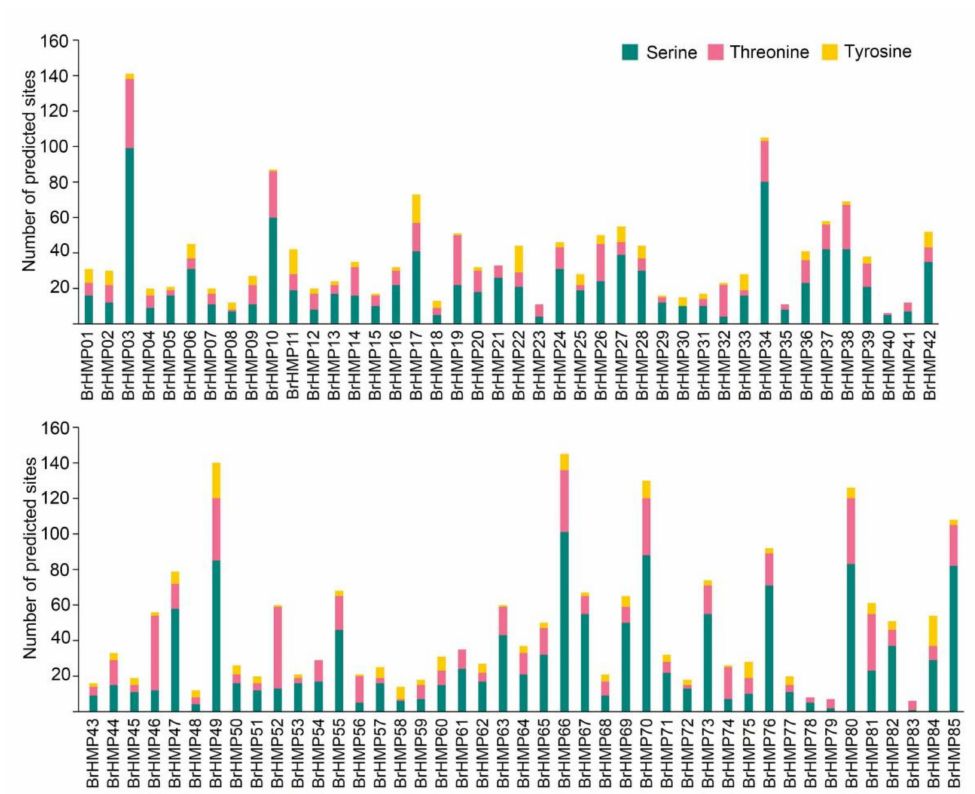
Figure 12. Distribution of predicted phosphorylation sites in BrHMP amino acid